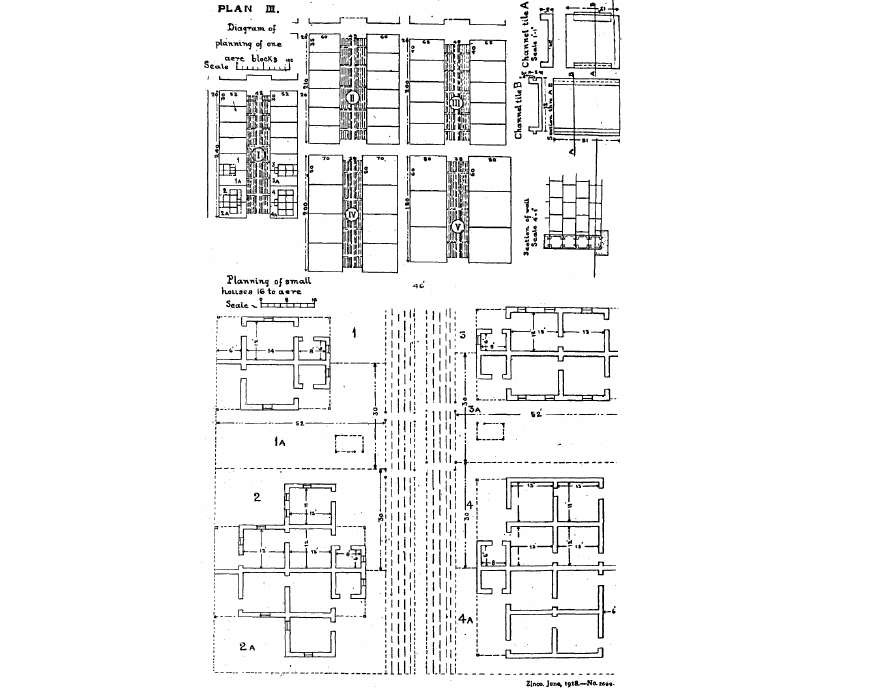
Figure 4. Indore expanding worker housing proposal. Source: Geddes (1918).